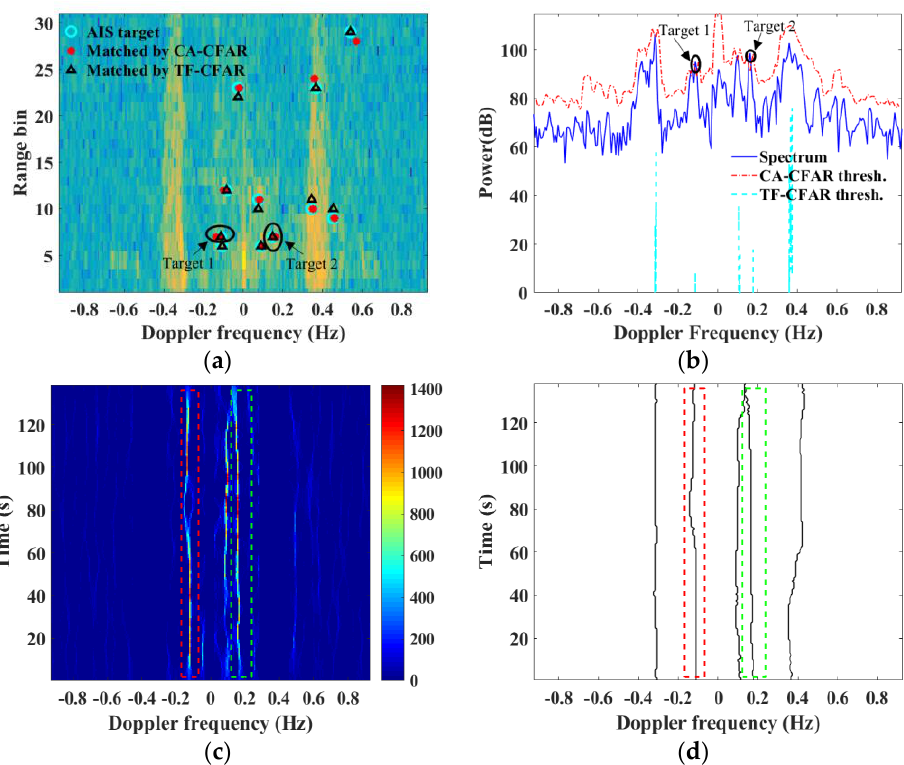
Figure 8. Same targets matched by TF-CFAR and CFAR at 06:51 on 25 September 2015. ( a ) Target-matching RD map; ( b ) power spectrum at the 7th range bin; ( c ) TF image at the 7th range bin; ( d ) extraction of target TF ridge at the 7th range bin.